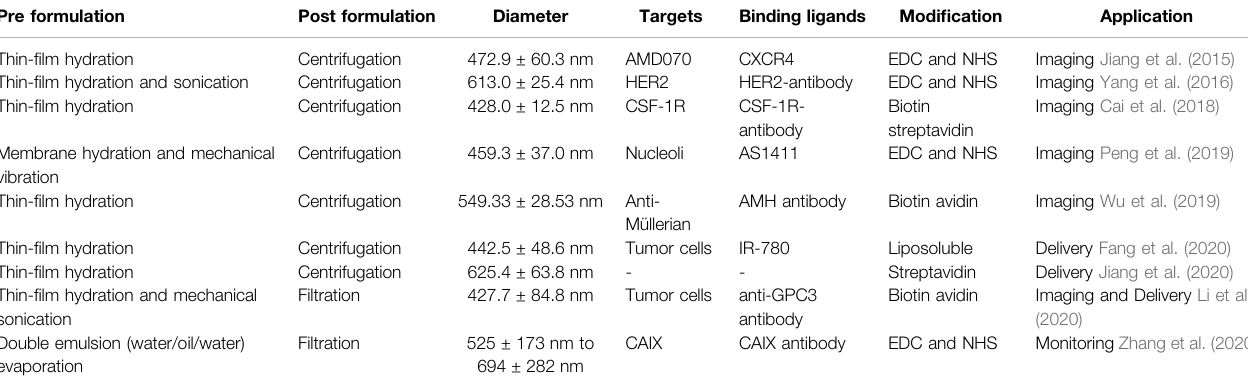
TABLE 2 | Different modi fi cations of nanobubbles (Jiang et al., 2015; Yang et al., 2016; Cai et al., 2018; Peng et al., 2019; Wu et al., 2019; Fang et al., 2020; Jiang et al., 2020; Li et al., 2020; Zhang et al., 2020). Pre